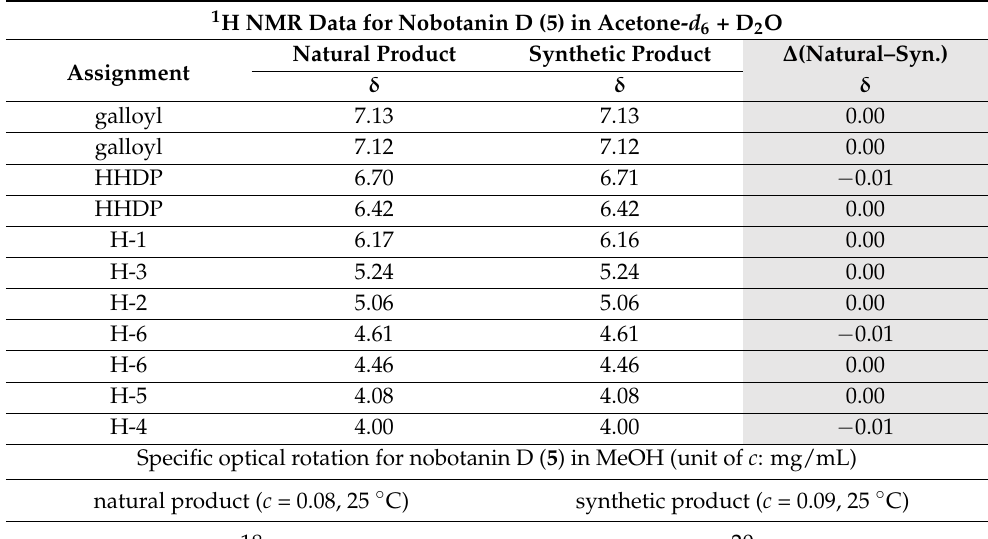
Table A1. Comparison of the spectral data between the synthetic and natural nobotanin D ( 5 ).